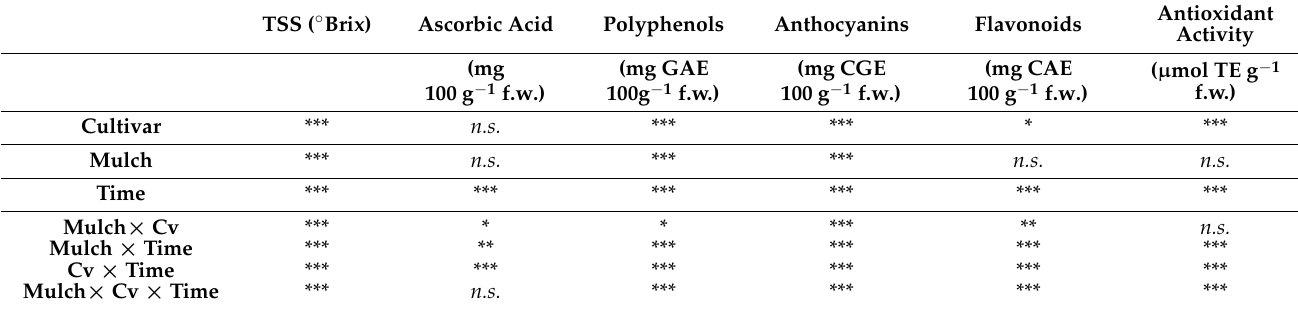
n.s . not significant; * p < 0.05, ** p < 0.01; *** p < 0.001. Fruits of cv Elide showed a steady TSS content in the first three sampling times and a peak in the last one (Figure 2). This behavior was common to all the mulching films, but TSS contents in the first three sampling times were significantly higher in PE (on average 8) than N5 and N18 (in the range of 6–7). Only in the last sampling date did TSS in fruits from N5 and N18 reach values like to those in PE. Fruits of cv Sabrina showed the same pattern of behavior, but TSS contents on N5 were in every sampling time significantly lower than those in fruits in N18 (Figure 2). Fruits of Sabrina ripened on PE and reached their maximum values 10.5 ◦ Brix in advance on 17 May with respect to biodegradable films that produced fruits with TSS 9–10 ◦ Brix in the last sampling against 8 ◦ Brix on